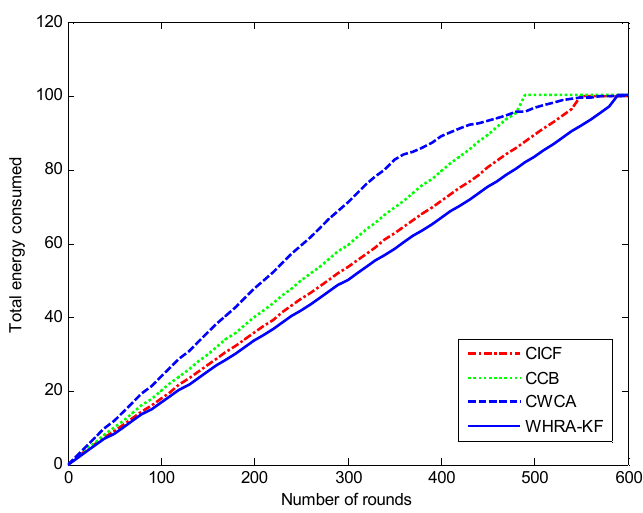
Figure 14. Total energy consumed by the four recommendation algorithms.